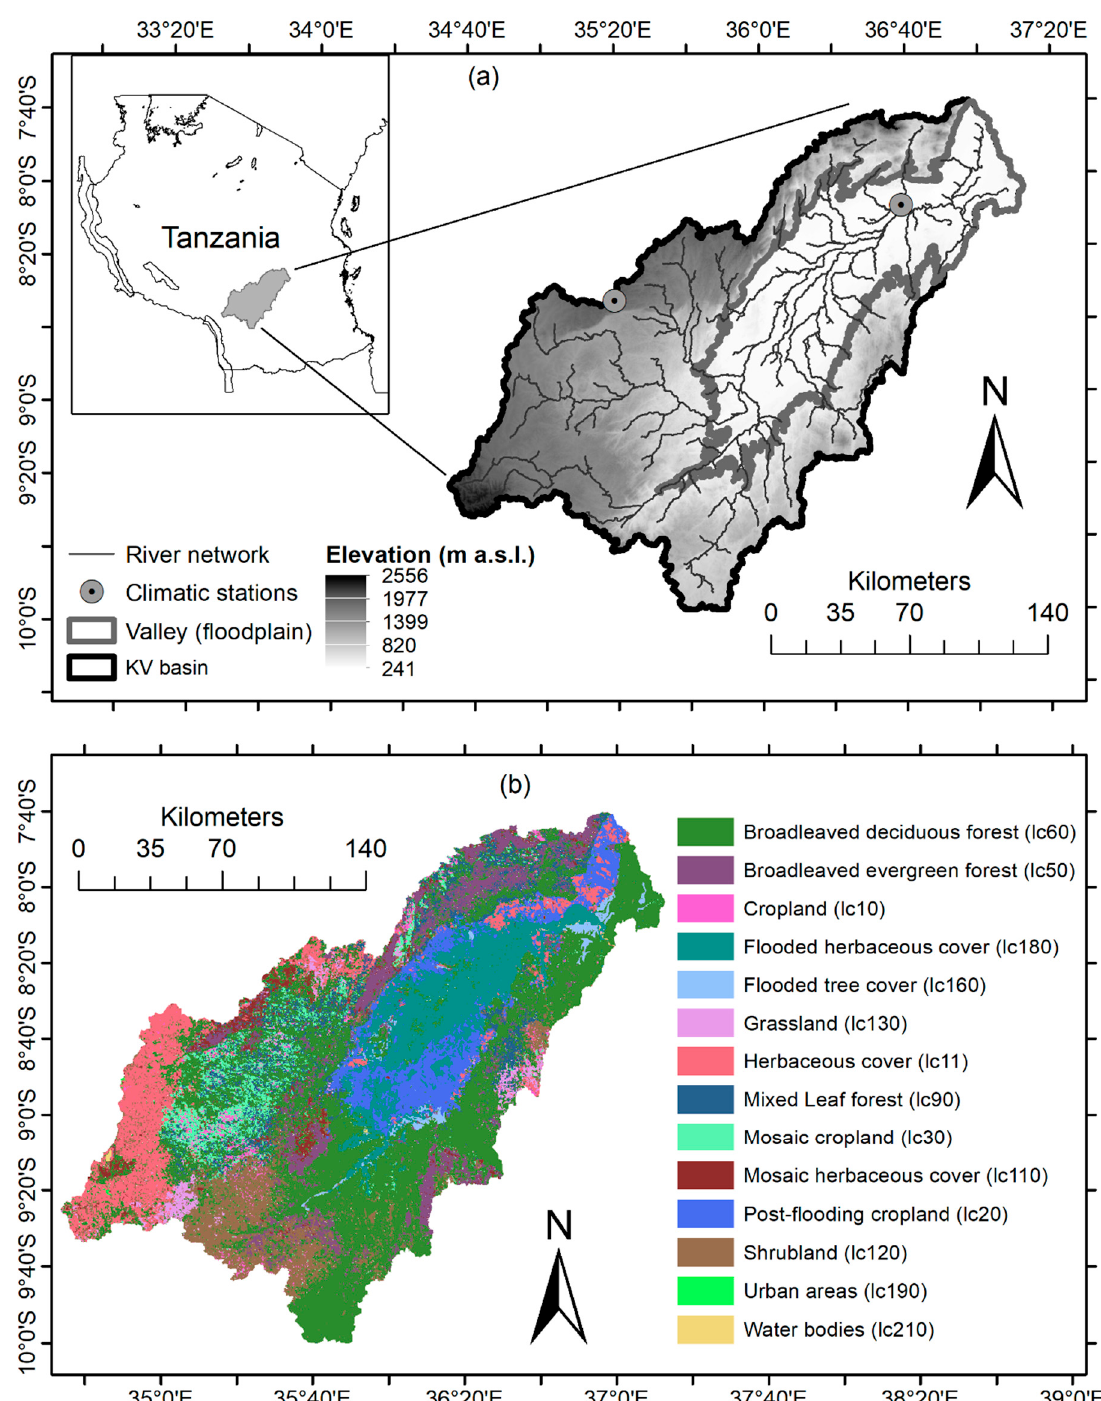
Figure 1. The study area map of Kilombero Valley (KV) river basin located in southern central Tanzania. ( a ) the stream network, climatic stations and wetland valley (floodplain). ( b ) Land cover classes of the Kilombero Valley (KV) river basin based on the 300 m spatial resolution global land cover map for the year 2015 provided by the European Space Agency (ESA) Climate Change Initiative (CCI).